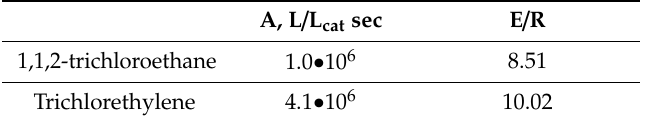
Table 15. Arrhenius parameters for hydrodechlorination of 1,1,2-trichloroethane and